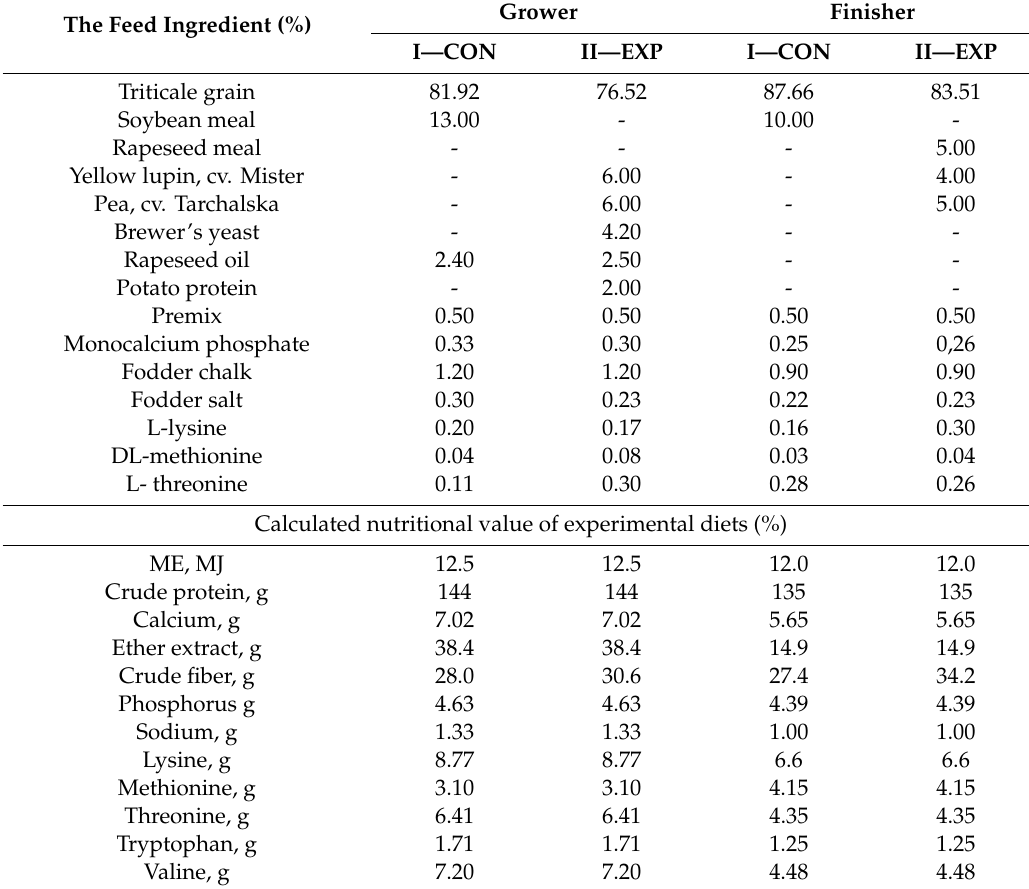
Table 2. Chemical composition of mixed feeds for pigs of the control and experimental groups, in two feeding